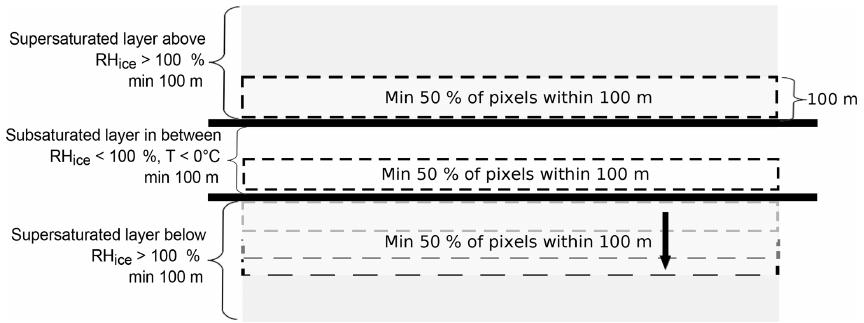
Figure 2. Conceptual sketch of criteria for how potential MLCs are identified. The grey areas symbolize the supersaturated layers; in between the black lines is the subsaturated layer. The dashed boxes symbolize the areas within which cloud occurrence is searched for. In the supersaturated layer below it is first searched for cloud occurrence within a box close to the top (dashed light grey); secondly, the box is moved lower down (dashed medium grey and